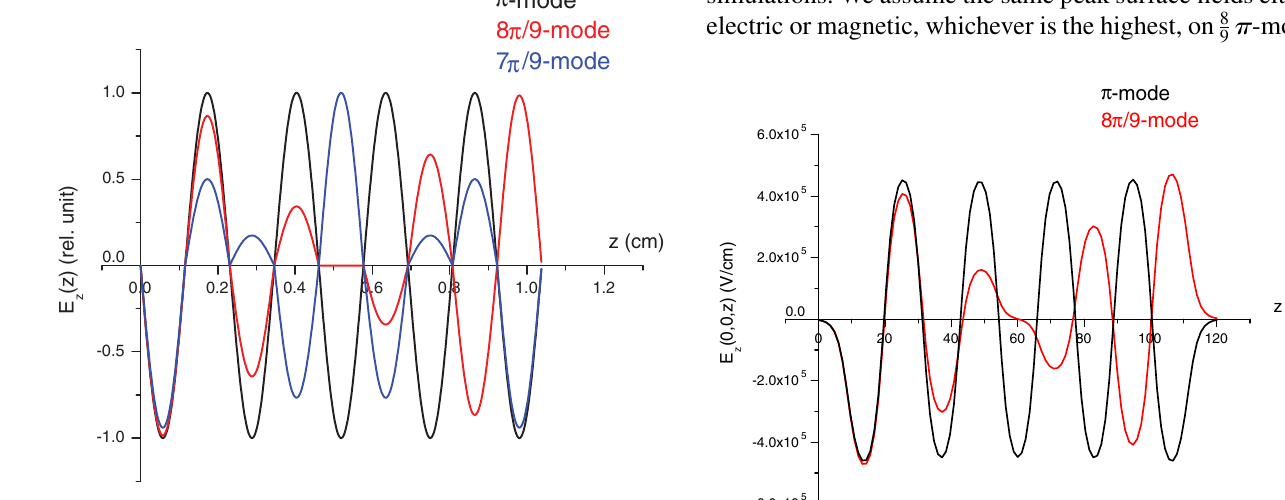
FIG. 1. (Color) Accelerating field distribution in a 9-cell cavity (cid:1) -, and 7 (cid:1) -modes correspondingly. The fields are for (cid:1) -, 8 9 9 calculated by the simplified formula (2).